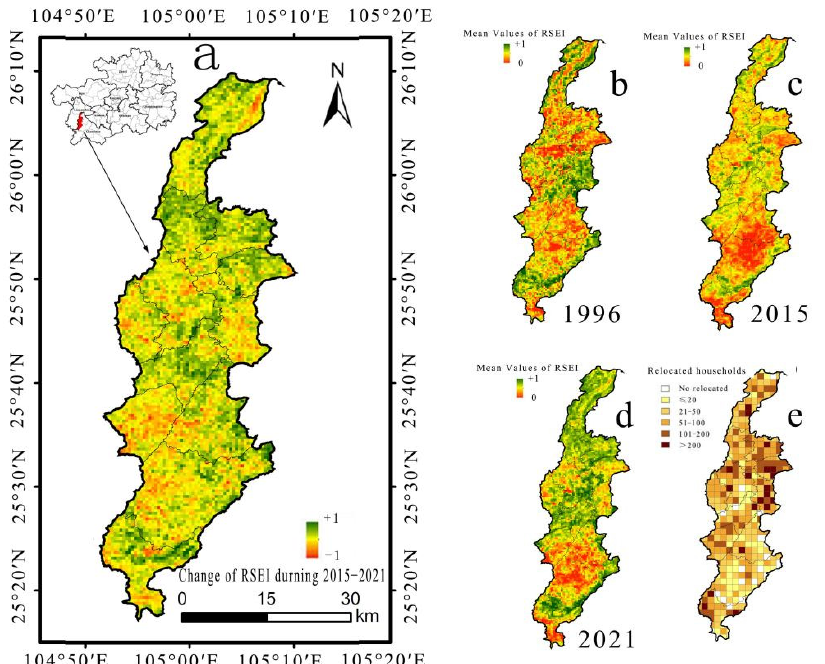
Figure 12. Pu’an RSEI change. ( a ) Pu’an RSEI change (2015–2021); ( b ) Pu’an RSEI in 1996; ( c ) Pu’an RSEI in 2015; ( d ) Pu’an RSEI in 2021; ( e ) PAR population distribution in Pu’an.